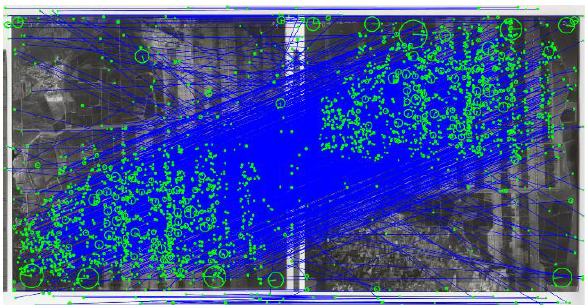
Figure 4. Example of SIFT